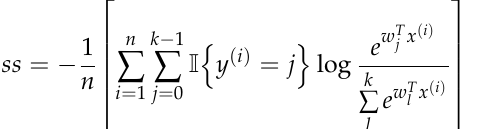
Figure 7. Presentation for the Filter Dataset of Qinghai with its elevation rendered.